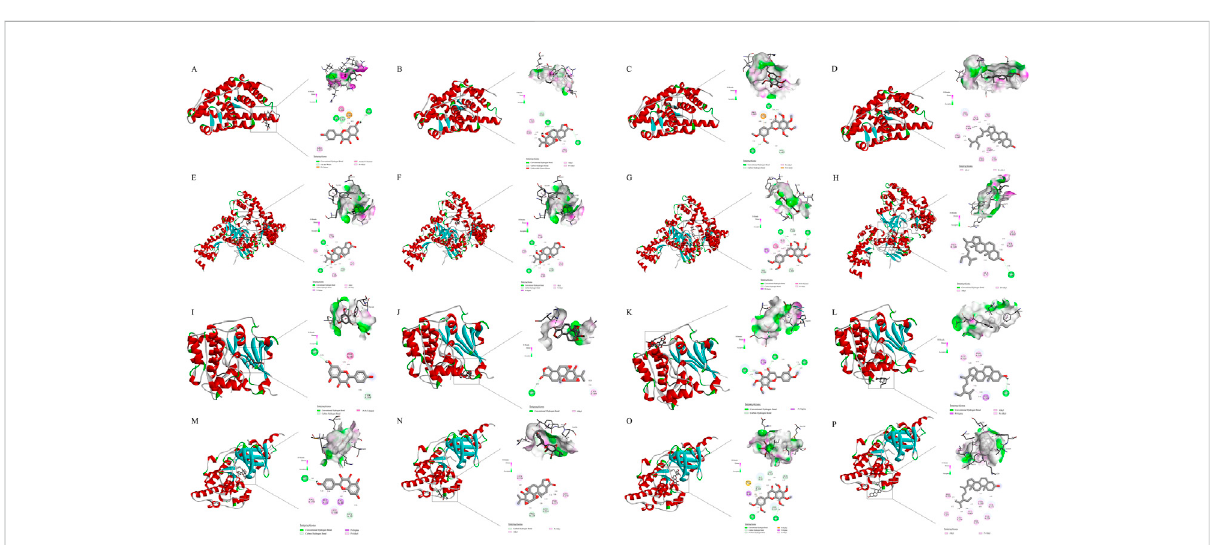
FIGURE 7 Molecular models of main compounds binding to their predicted key protein targets. (A) : molecular docking diagram of PTGS2(5F19) and kaempferol; (B) molecular docking diagram of PTGS2(5F19) and triptolide; (C) molecular docking diagram of PTGS2(5F19) and nobiletin; (D) molecular docking diagram of PTGS2(5F19) and schottenol; (E) molecular docking diagram of RELA (3QXY) and kaempferol; (F) molecular docking diagram of RELA (3QXY) and triptolide; (G) molecular docking diagram of RELA (3QXY) and nobiletin; (H) molecular docking diagram of RELA (3QXY)andschottenol; (I) moleculardockingdiagramofAKT1(3CQU)andkaempferol; (J) molecular dockingdiagramofAKT1(3CQU)andtriptolide; (K) moleculardockingdiagramofAKT1(3CQU)andnobiletin; (L) :moleculardockingdiagramofAKT1(3CQU)andschottenol; (M) :moleculardocking diagram of MAPK8(2XRW) and kaempferol; (N) : molecular docking diagram of MAPK8(2XRW) and triptolide; (O) : molecular docking diagram of MAPK8(2XRW) and nobiletin; (P) : molecular docking diagram of MAPK8(2XRW) and